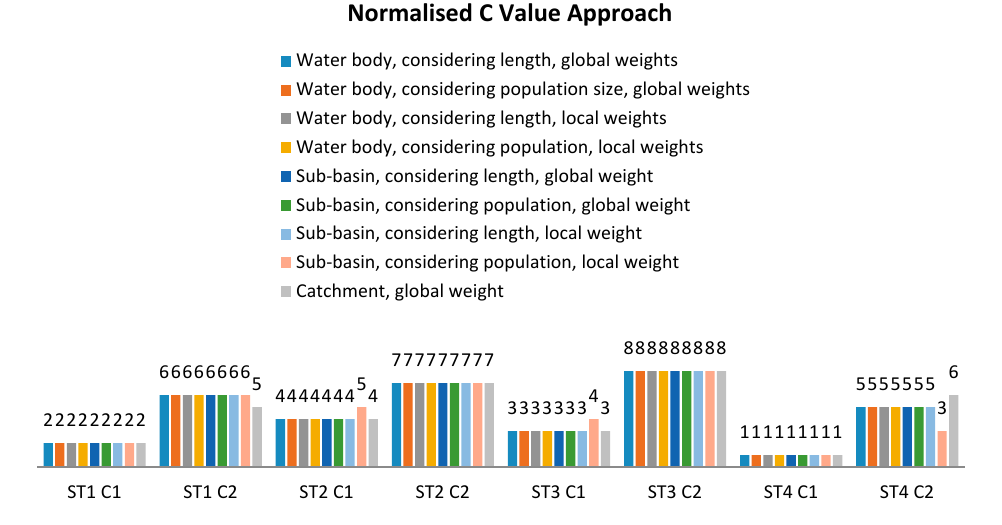
Figure 8. The results from applying TOPSIS on the water body, sub-catchment and basin scales for the different decision inputs we consider. The final rank results obtained at the water body and sub-catchment scale are aggregated using the normalised TOPSIS C value approach.